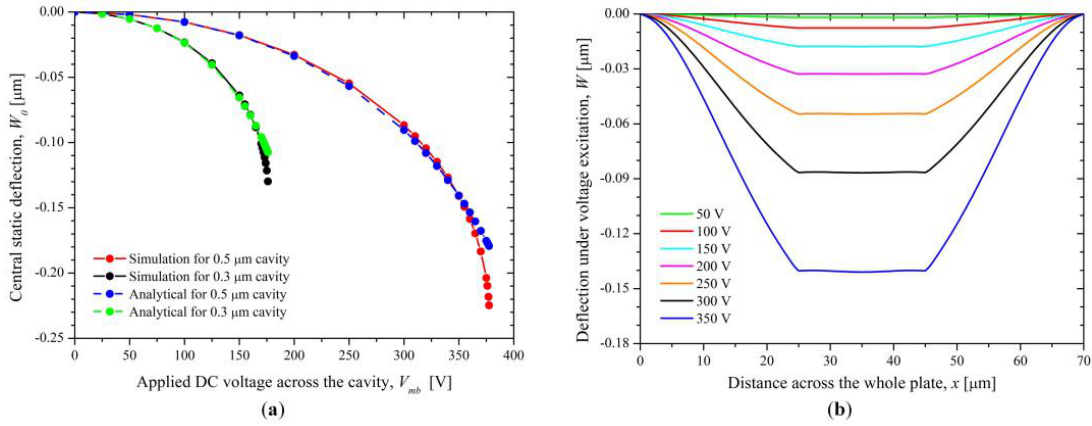
Figure 10. ( a ) Center static deflection and ( b ) deflection across the whole plates at CMUT operation under the DC voltage excitation.